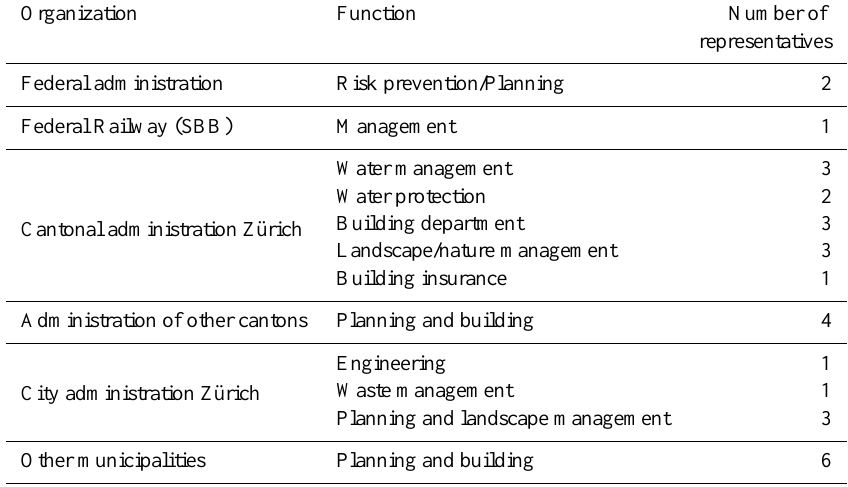
Table 2. Composition of the accompanying group.